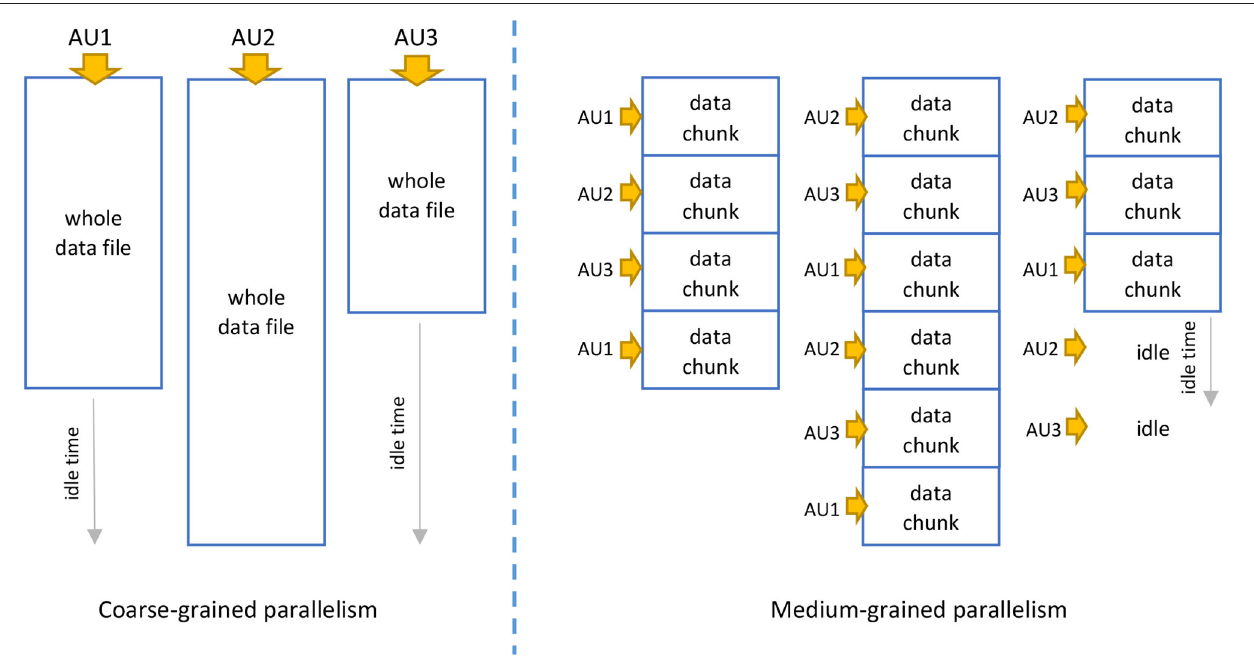
FIGURE 3 | Granularity of parallelism applied in various storage scenarios: (left) NGS data processed as a whole by many Allocation Units (AUs), (right) processing NGS data divided into